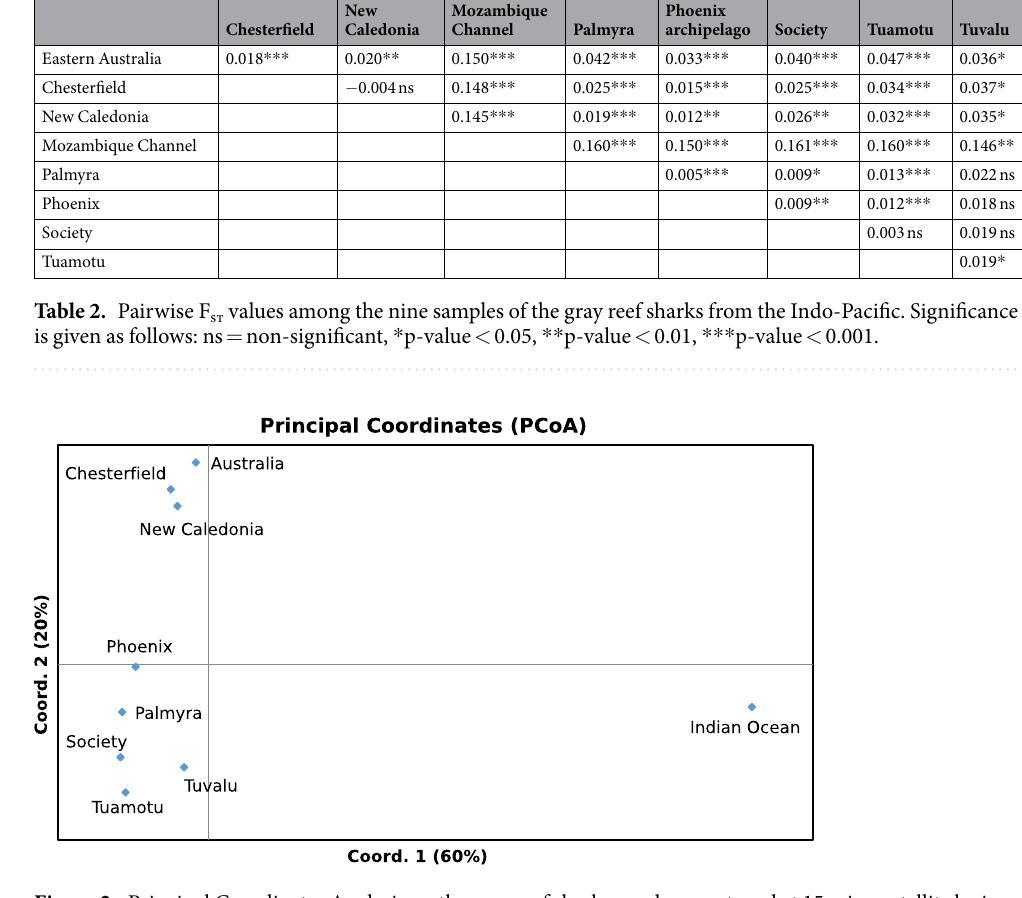
Figure 2. Principal Coordinates Analysis on the gray reef shark samples genotyped at 15 microsatellite